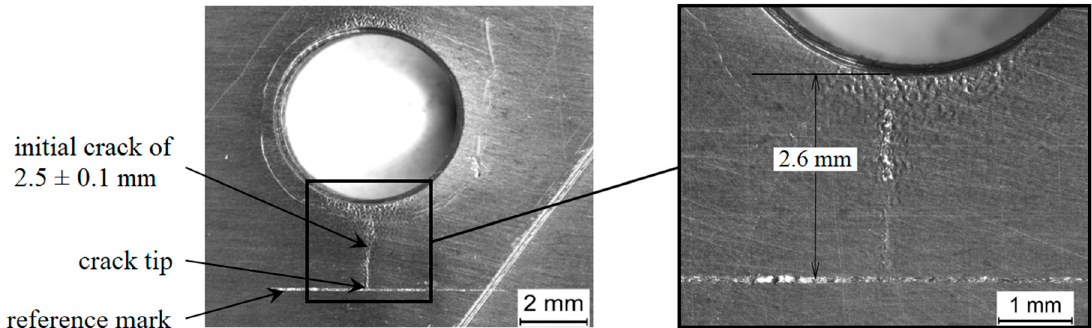
Figure 4. Specimen with a fastener hole where the initial crack length in the hole is 2.5 ± 0.1 mm.